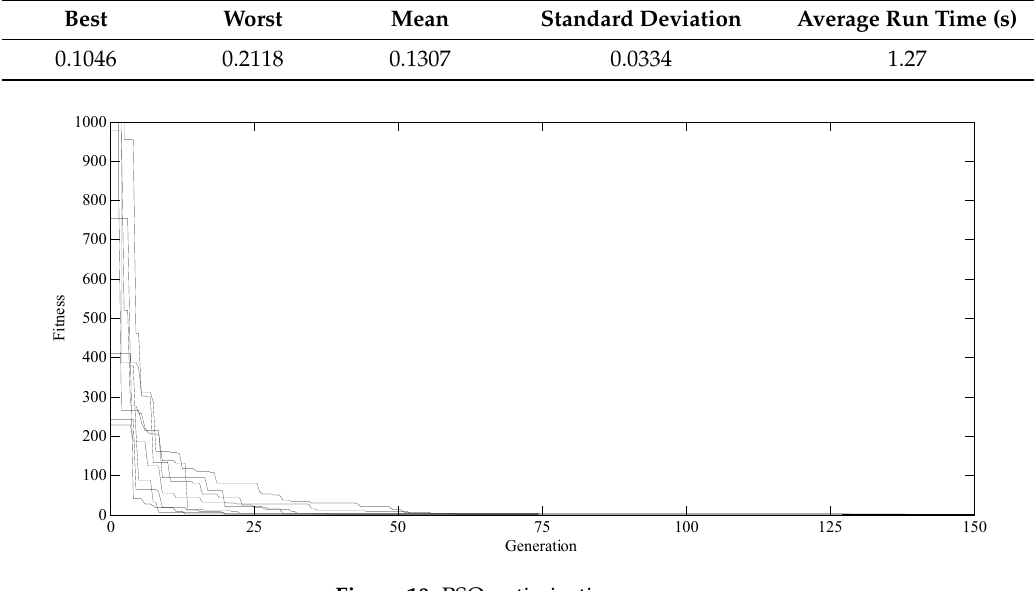
Figure 10. PSO optimization process.